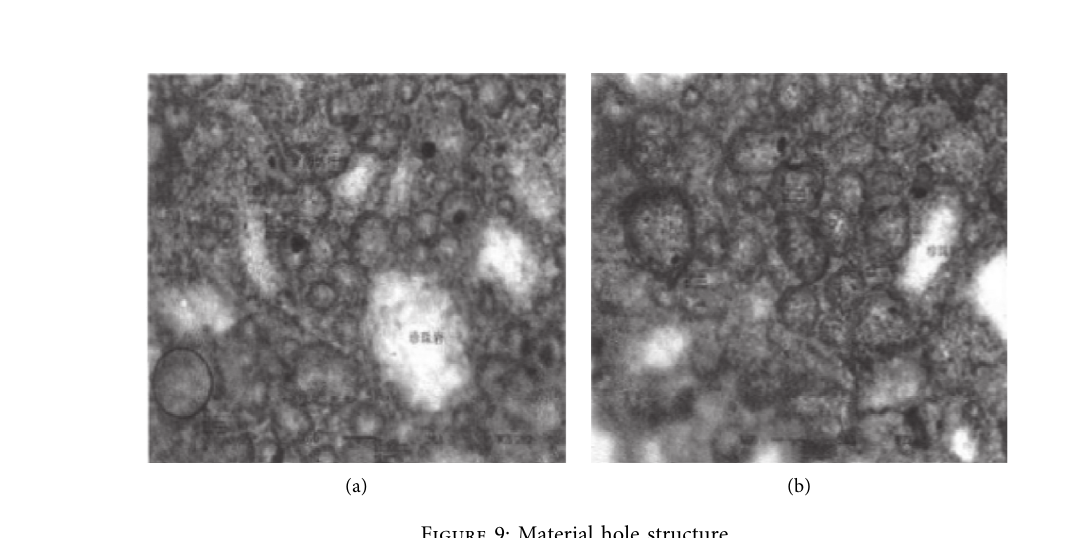
Figure 9: Material hole structure.